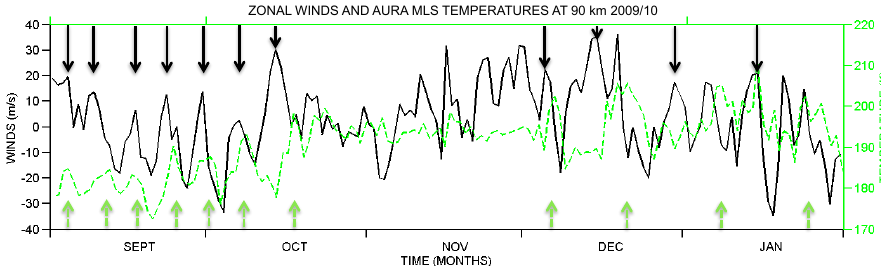
Fig. 4. The daily zonal winds and MLS temperatures at ∼ 90 km measured over BLO for the interval September 2009–January 2010. Wind maxima occurring at planetary wave periods ( ∼ 5 and 16 days) are indicated by the arrows, wind on the top axis and temperature on the bottom axis.